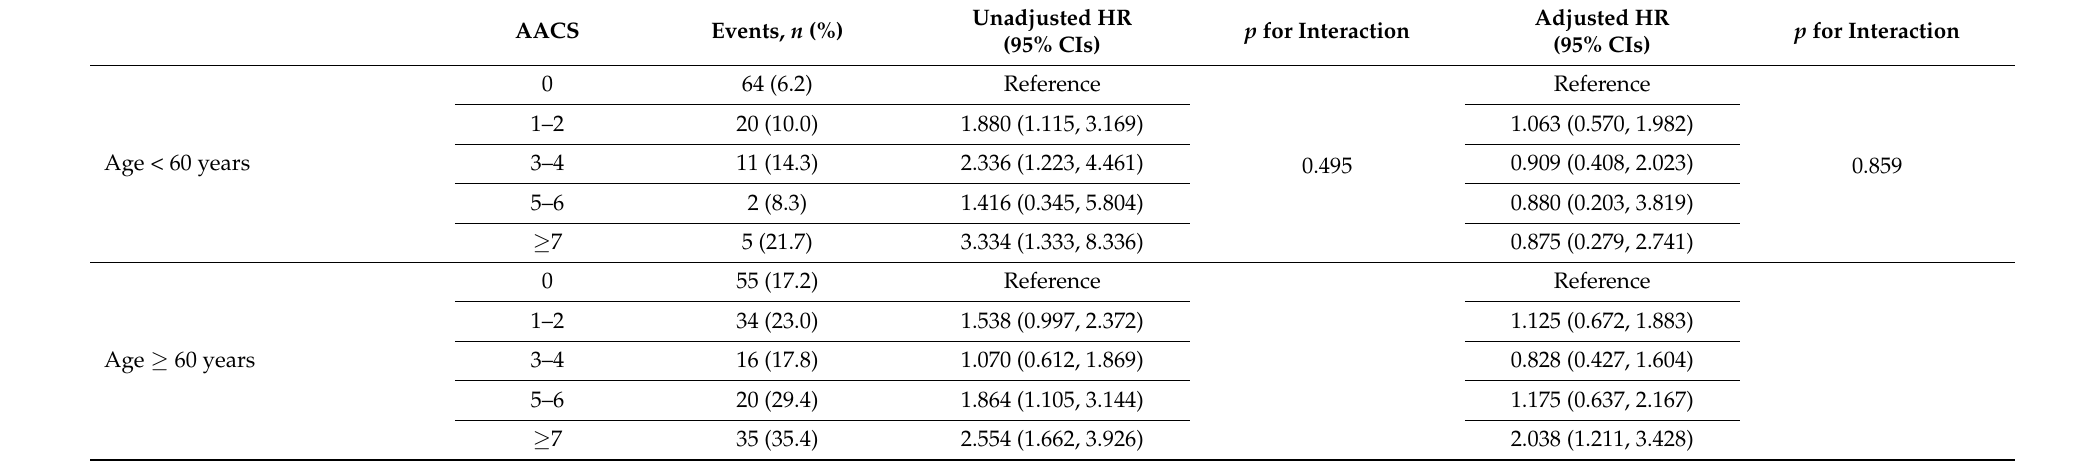
Table 4. Cox regression analysis of AACS for the primary outcome (non-fatal CV events and all-cause death) in various